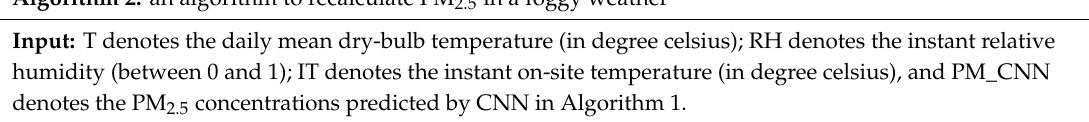
Algorithm 2: an algorithm to recalculate PM 2.5 in a foggy